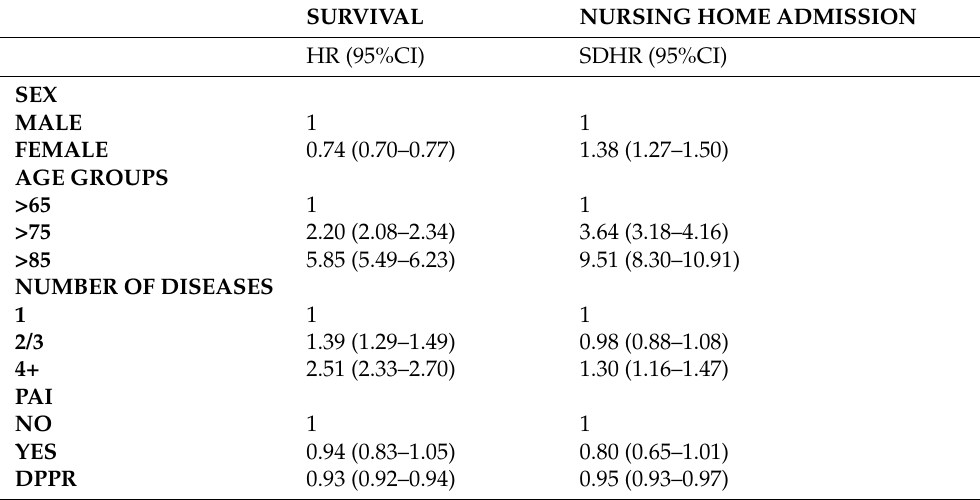
Table 3. Cox proportional hazard model on 12-month mortality (hazard ratios with 95% confidence intervals), and Fine–Grey model for the incidence of nursing home admission (subdistribution HRs with